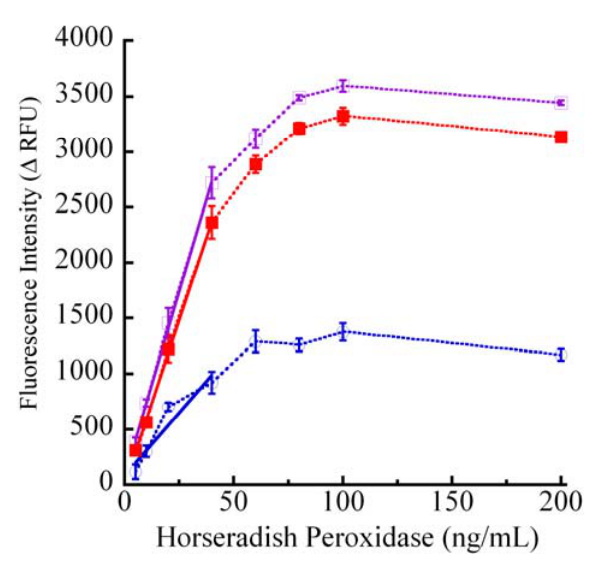
Figure 8. Peroxidase-catalyzed CA oxidation. Increasing concentrations of horseradish peroxidase were used to oxidize 250  M CA in the presence of 250  M H using 96-well UV-transparent microplate. The reaction was stopped using 100 mM NaOH and the fluorescence was measured at 416 nm following excitation using 290 (open squares, purple), 310 (closed squares, red) and 340 nm (open circles, blue) wavelengths. Dotted tracings are interpolations and solid tracings are the linear curve fit (5 to 40 ng/mL peroxidase). Linearity ( r 2 ) values were 0.999 (290 nm, solid purple), 0.999 (310 nm, solid red) and 0.903 (340 nm, solid